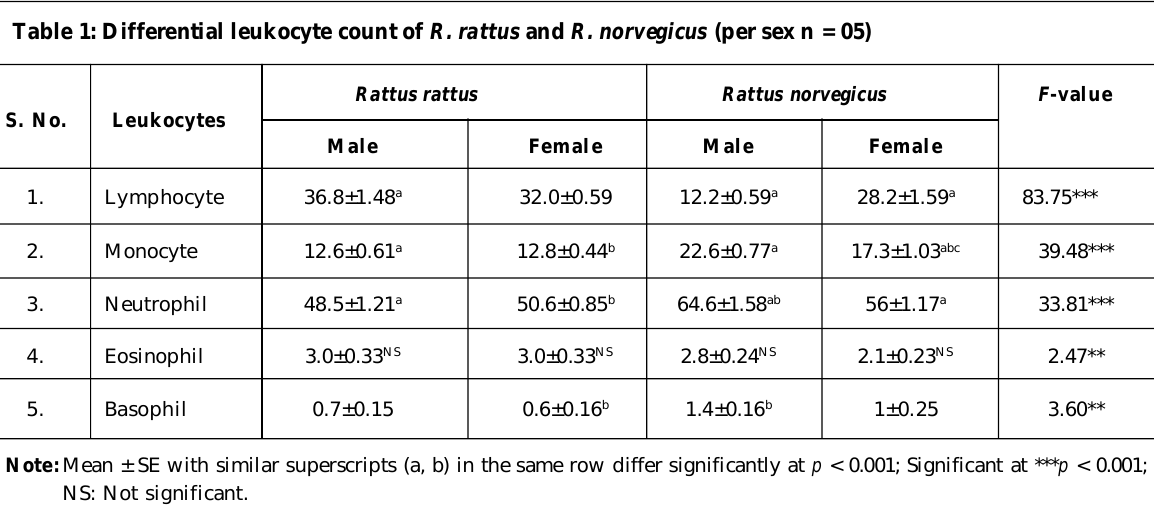
Table 1: Differential leukocyte count of R. rattus and R. norvegicus (per sex n = 05)